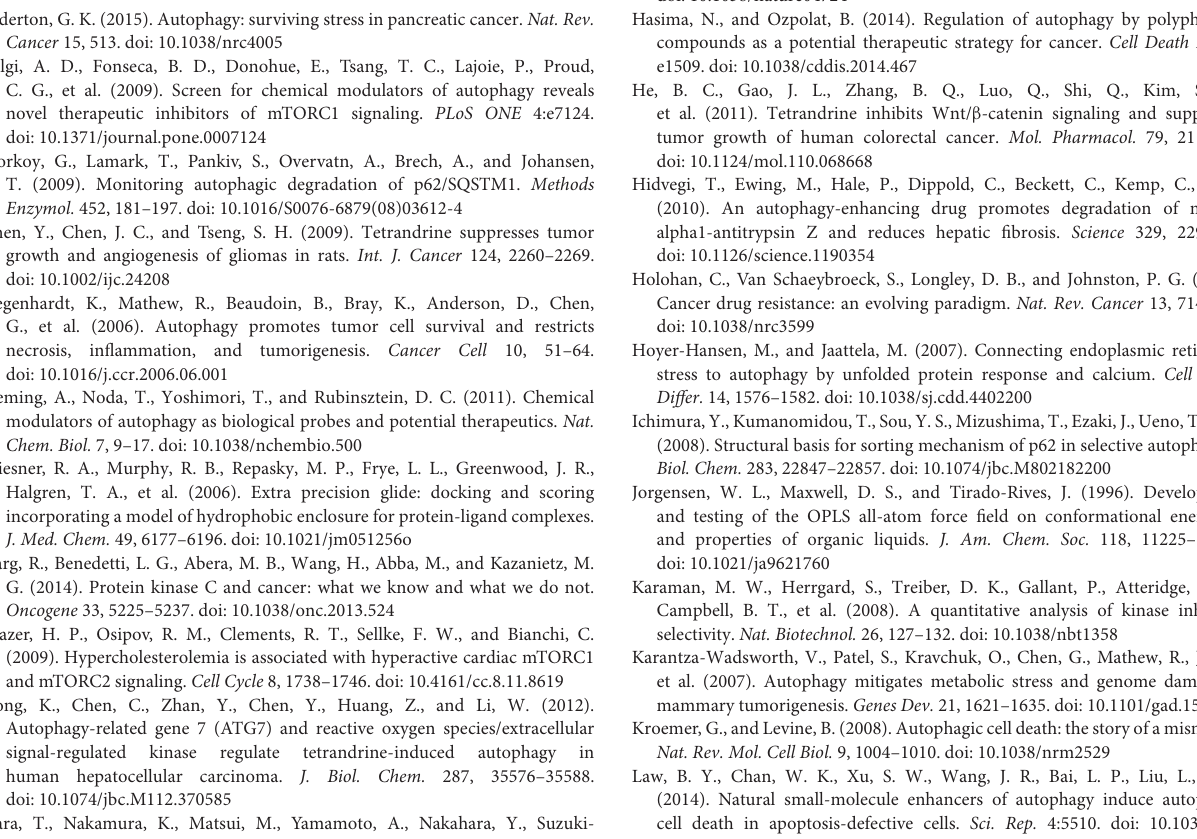
fraction (100 µ g/ml) and (B) partially purified fractions (50 µ g/ml) from the root of Stephania tetrandra , for 16h. Representative fluorescence images depicting the formation of GPF-LC3 puncta were shown. (C) Time lapse pictures (with time lapse video, Video 1) on the induction of autophagy in MCF-7 cells treated with 5 µ M of tetrandrine (duration for 6 h) were shown. The panel of time lapse fluorescent pictures showed the progressive increase in the number of GFP-LC3 punctate formation (yellow arrows) in cells from 0 to 6 h, and finally, cell death as indicated by the burst of cells (red arrows). Figure S2 | Tetrandrine increases expression of p62 mRNA level. (A) MCF-7 cells were treated with tetrandrine (5 µ M) from 0 to 48h. The induction of p62 mRNA were assessed by real time-PCR and normalized against β -actin as the housekeeping gene. (B) MCF-7 cells were pre-treated with actinomycin D (ACD) (2.5 µ g/ml) for 1 h before tetrandrine (5 µ M) treatment for 16 h. Cell lysates were then analyzed for p62 and β -actin. Columns, means of three independent experiments; bars, SEM. ∗∗ P < 0.01. Figure S3 | Tetrandrine induces autophagy via a calcium or AMPK independent pathway. (A) Representative pictures showing punctated GFP fluorescence in GFP-LC3 expressing MCF-7 cells treated with Tet (5 µ M) or DMSO (ctrl) in the presence or absence of CaMKK- β inhibitor, STO-609 (25 µ M), or (B) calcium chelator, Bapta-AM (25 µ M), or (C) AMPK inhibitor, compound C (10 µ M) for 16h. Cells were then fixed for fluorescence imaging and cells counting. The results were representative images from three independent experiments. Table S1 | Profiling of tetrandrine at two concentrations (1 and 10 µ M) against 300 wild-type protein kinases. Kinase with residual activity < 50% were highlighted in